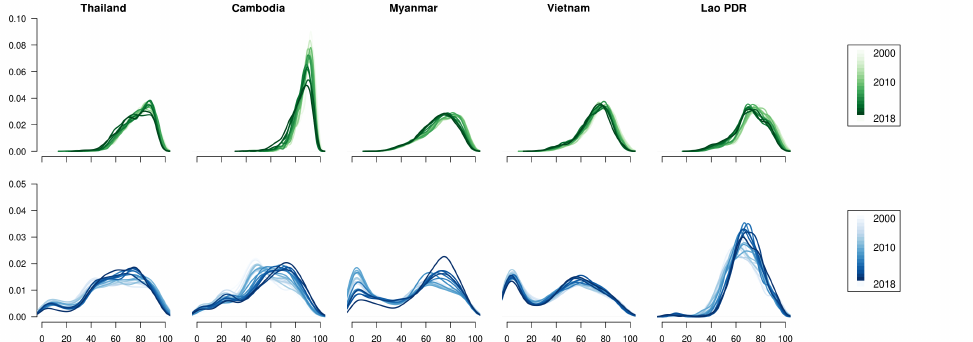
Figure 9. Probability density functions for anthropogenic change. The green charts show the ‘Generic to Specific’ cropland distributions per country, filtered using the ‘Specific to Generic’ Forest data with a threshold of 62%. The blue charts show the ‘Specific to Generic’ Forest distribution of the ‘Generic to Specific’ Cropland layers with a threshold value of